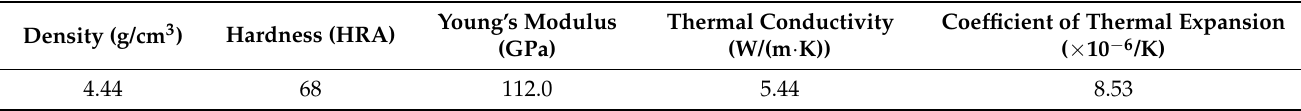
Table 5. Properties of the Ti6Al4V.